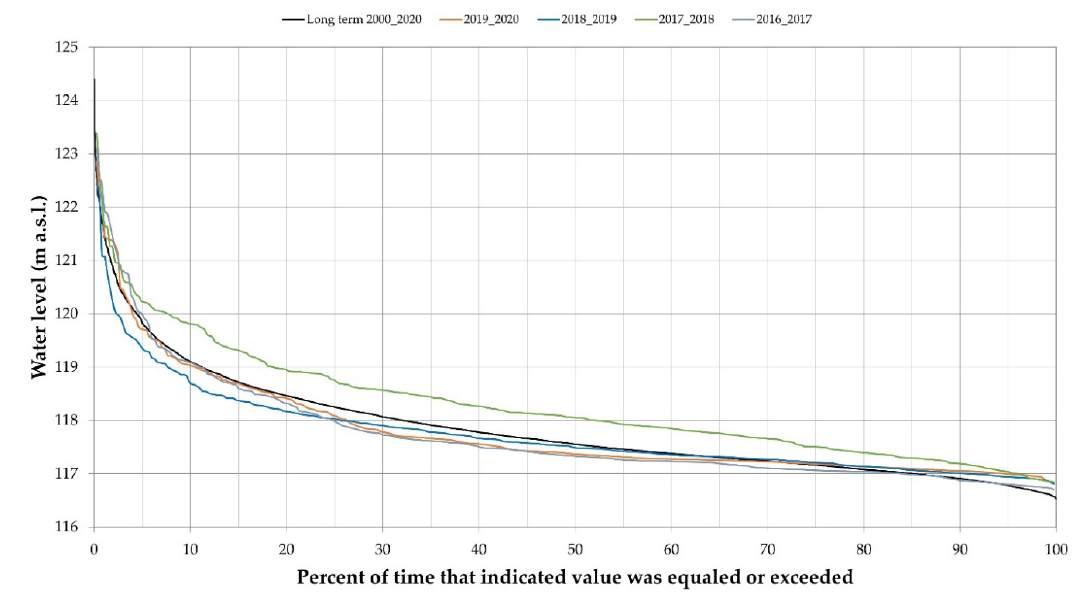
Figure 3. Sava River water level duration curves.